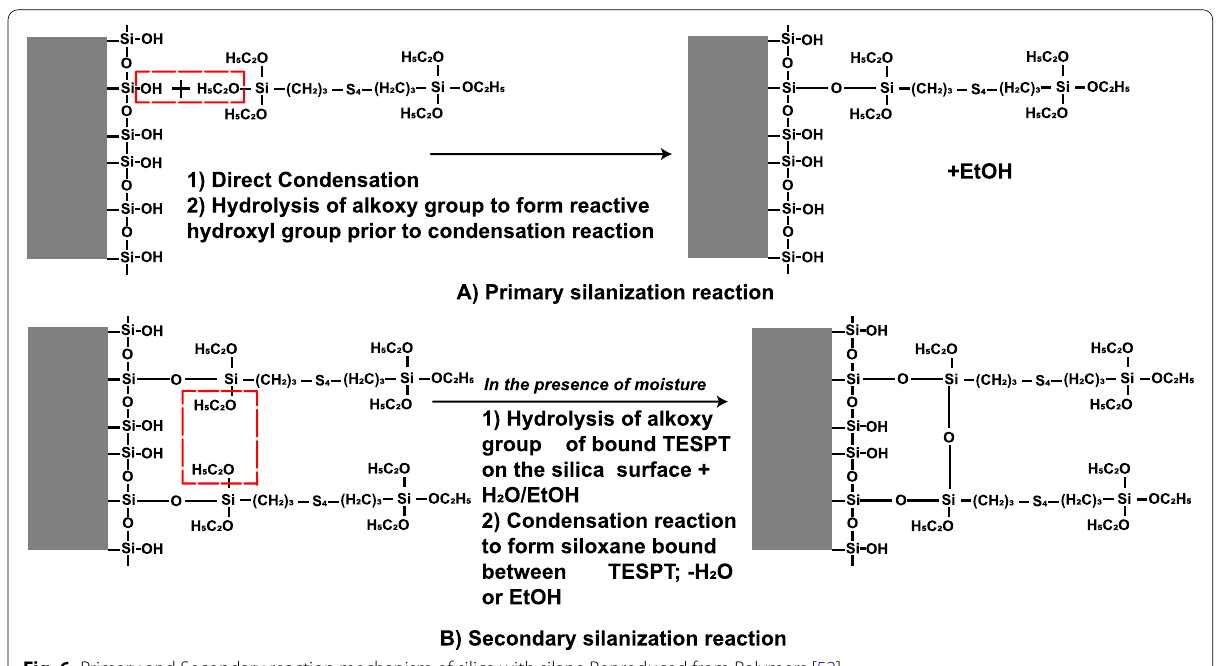
Fig. 6 Primary and Secondary reaction mechanism of silica with silane Reproduced from Polymers [52]